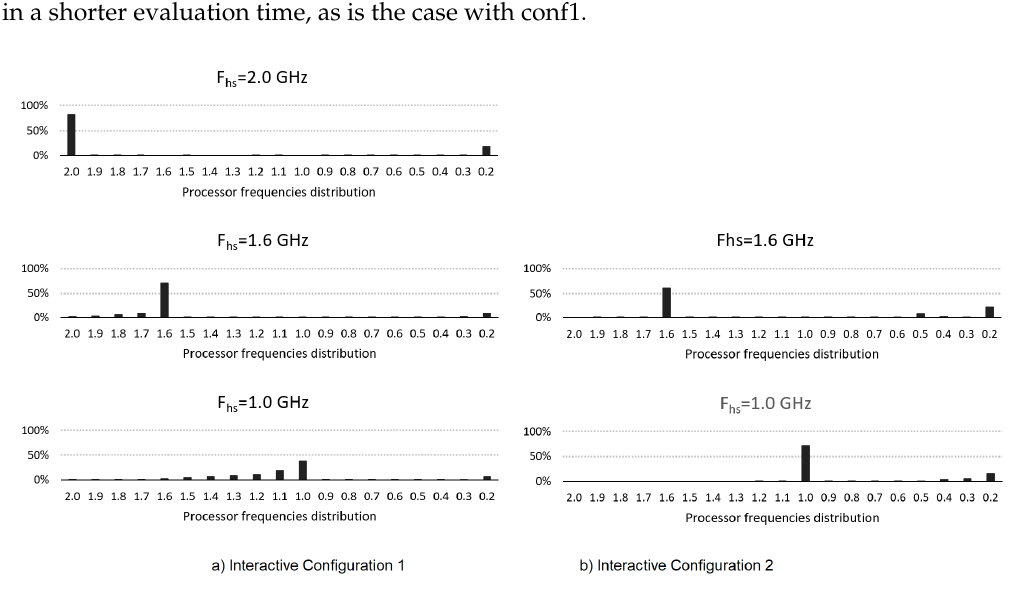
Figure 7. Core frequency distribution for each configuration for Vid1 .